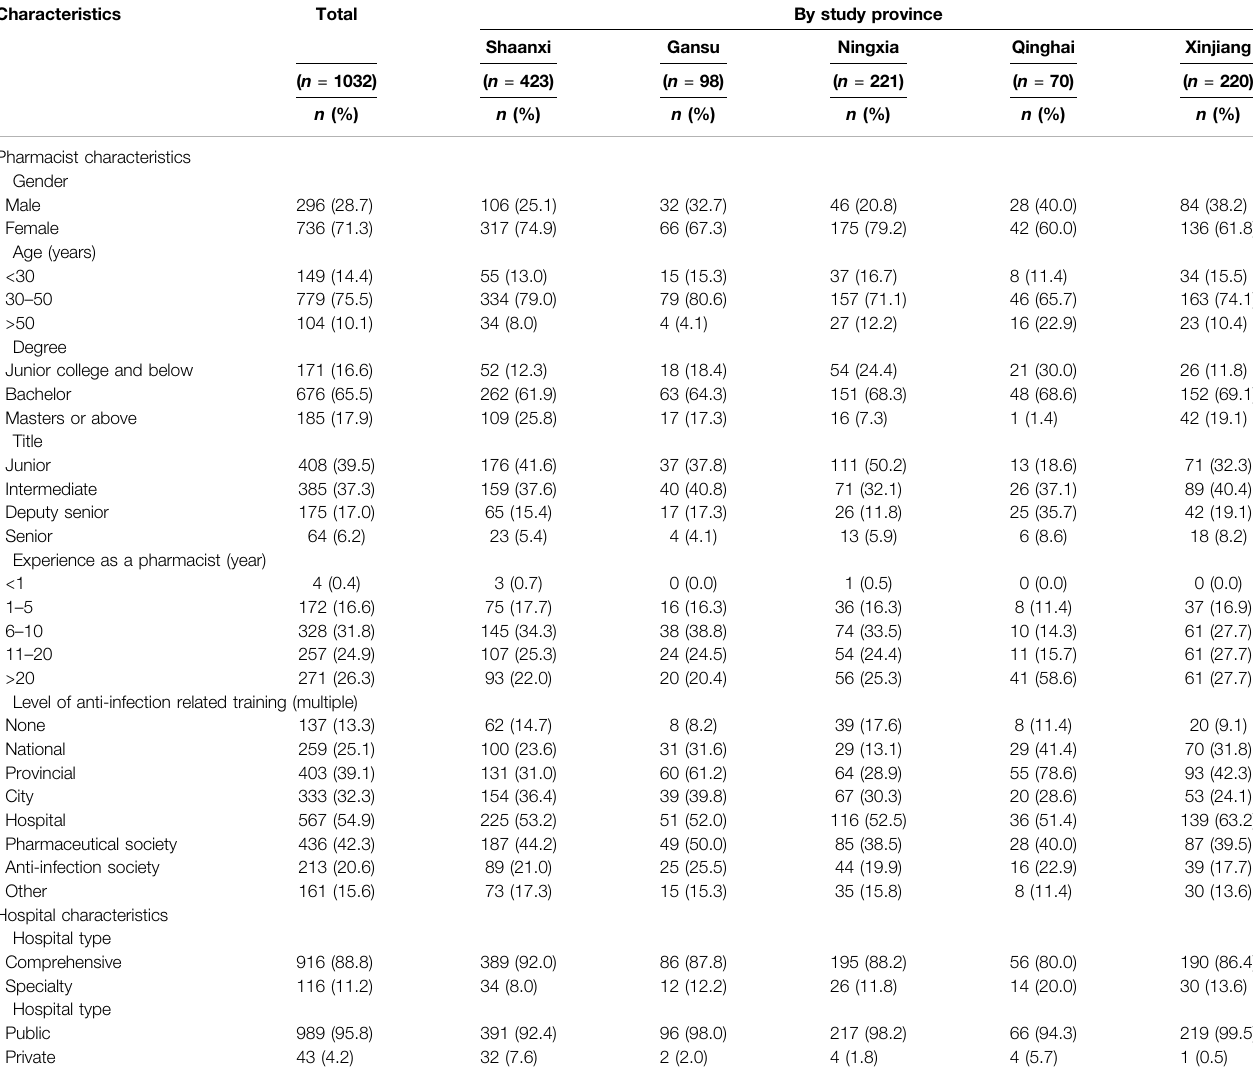
TABLE 1 | Characteristics of participating hospital pharmacists.